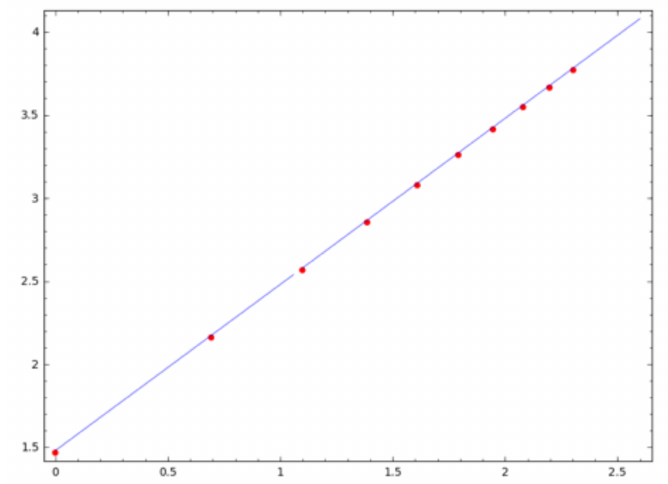
Figure 1. Log–log plot of the variances as function of the steps ( h k , v h k ) at an EEG signal in the simulation of driving a military vehicle task in Afghanistan